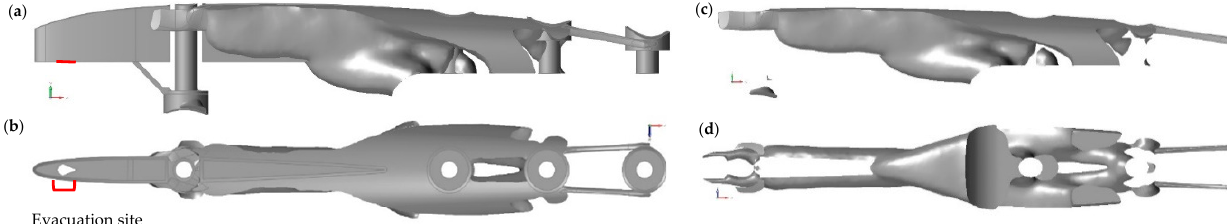
Figure 12. D(9) core together with interior partitions of bulb; ( a ) side horizontal view, ( b ) top horizontal view; while isolated optimized core D(9) shape; ( c ) side, ( d ) bottom. The overall longitudinal length of the component is 290 mm. Stress analysis, on original and optimized shapes, reports localized stresses in the rear edge region on the rudder vertical socket (Figure 13a). The localized stress concentration is present in all load cases and models and it is considered to not represent a